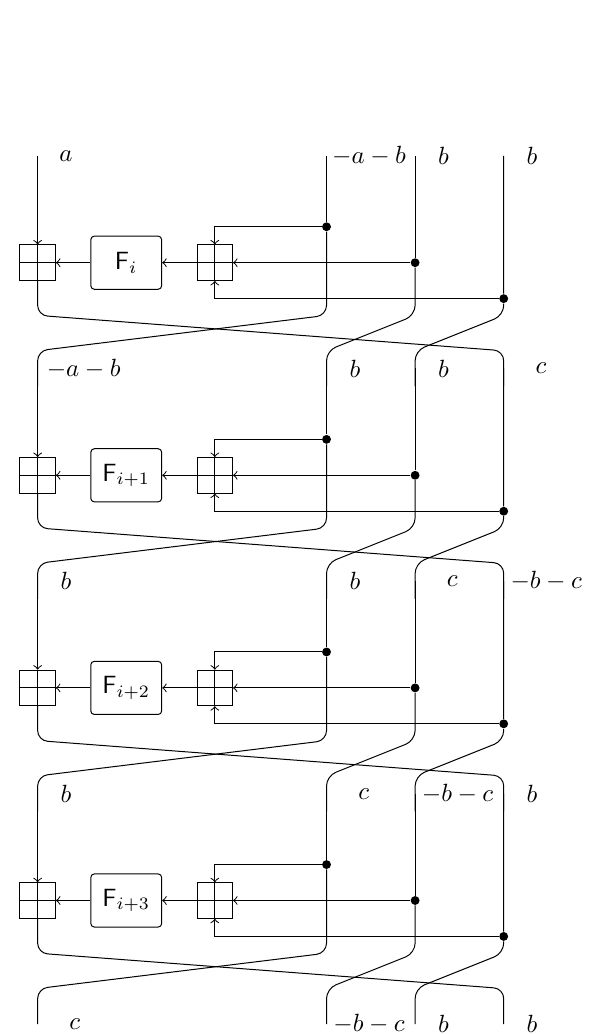
Figure 4: Truncated differential for a contracting generalized Feistel cipher with t = 4 branches. The probability of this trail is 1 /N . In characteristic two, the minus signs may be